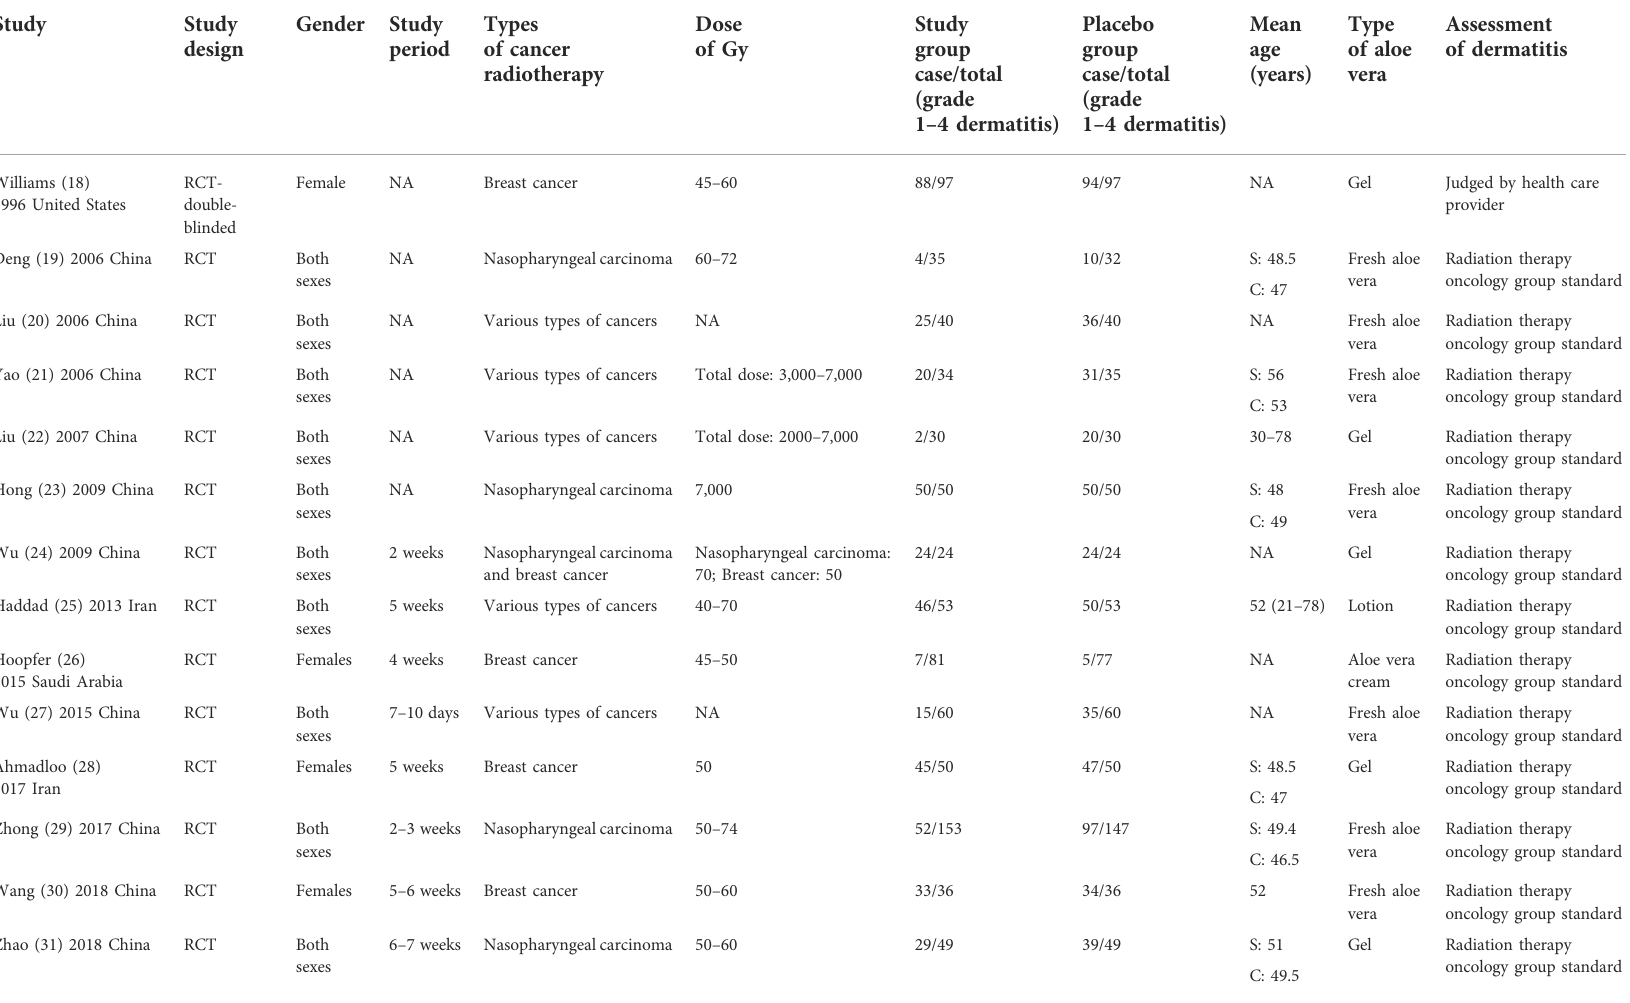
TABLE 1 Characteristics of the fourteen included